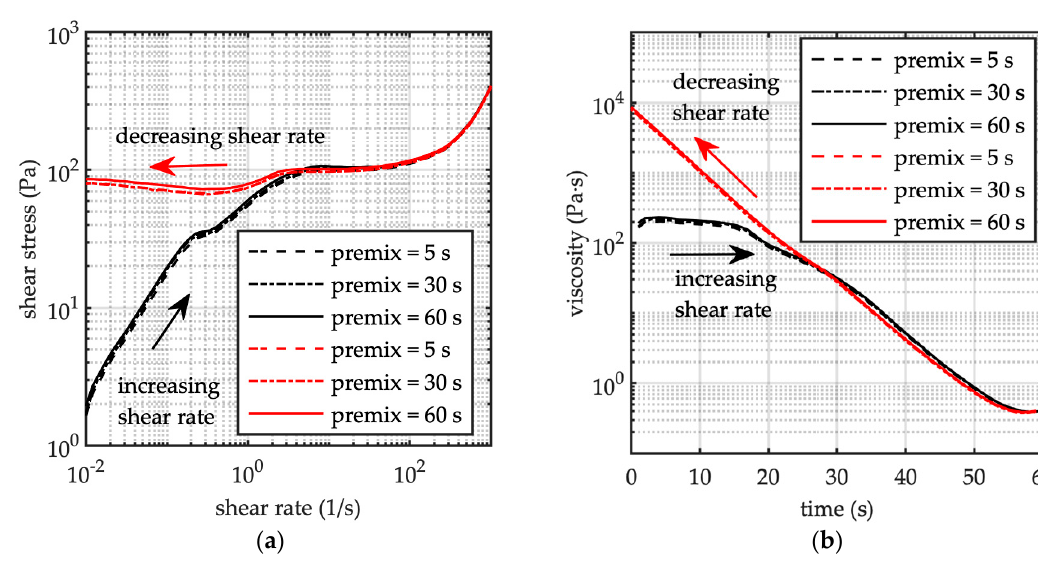
Figure 5. C = 52%. ( a ) Flow curves after different premixing period (runs F8, F7, F9—see Table 1—in the legend from the top to the bottom). ( b ) Viscosity over time for the same runs. Black line: increasing shear ramp (time = 0–60 s); red line: decreasing shear ramp (time = 60–0 s).